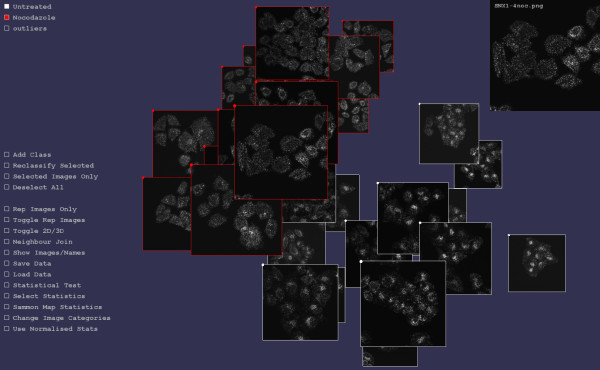
Distinguishing untreated/treated protein localisation. Two sets of images are visualised in iCluster: one for which the protein SNX1 has been fluorescently tagged and imaged (white borders); and one for which SNX1 has similarly been imaged in cells treated with nocodazole (red borders). For each image, TAS are generated and mapped into 3 dimensions. The visual difference between nocodazole treated and control images is quite subtle with the control images exhibiting slightly more peri-nuclear clustering than the nocodazole treated case. However, the above result of statistic generation and mapping clearly shows that the treated and control images have been distinguished. Each image is shown connected to its nearest neighbour in the 3D space. The top right corner shows the current mouse selected image in more detail.